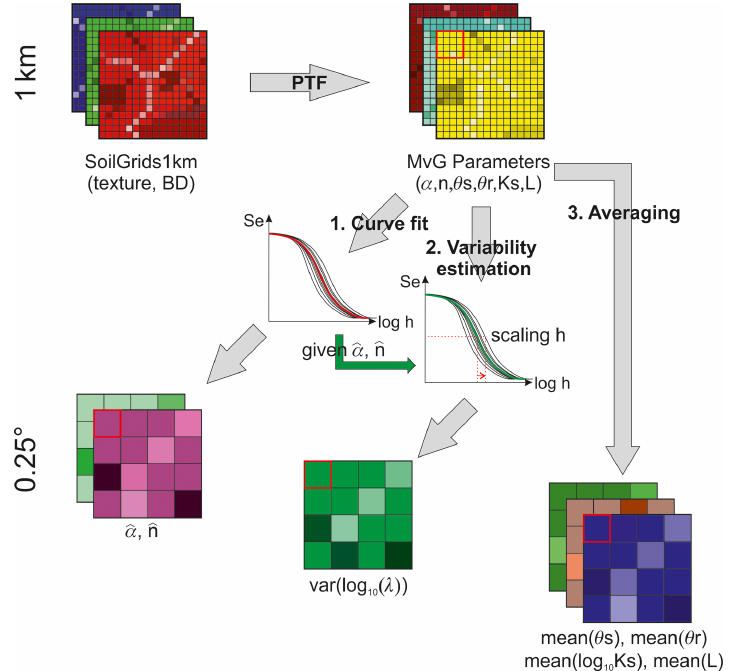
Figure 1. Proposed method to aggregate soil hydraulic properties and sub-grid variability of soil water retention and hydraulic conductivity